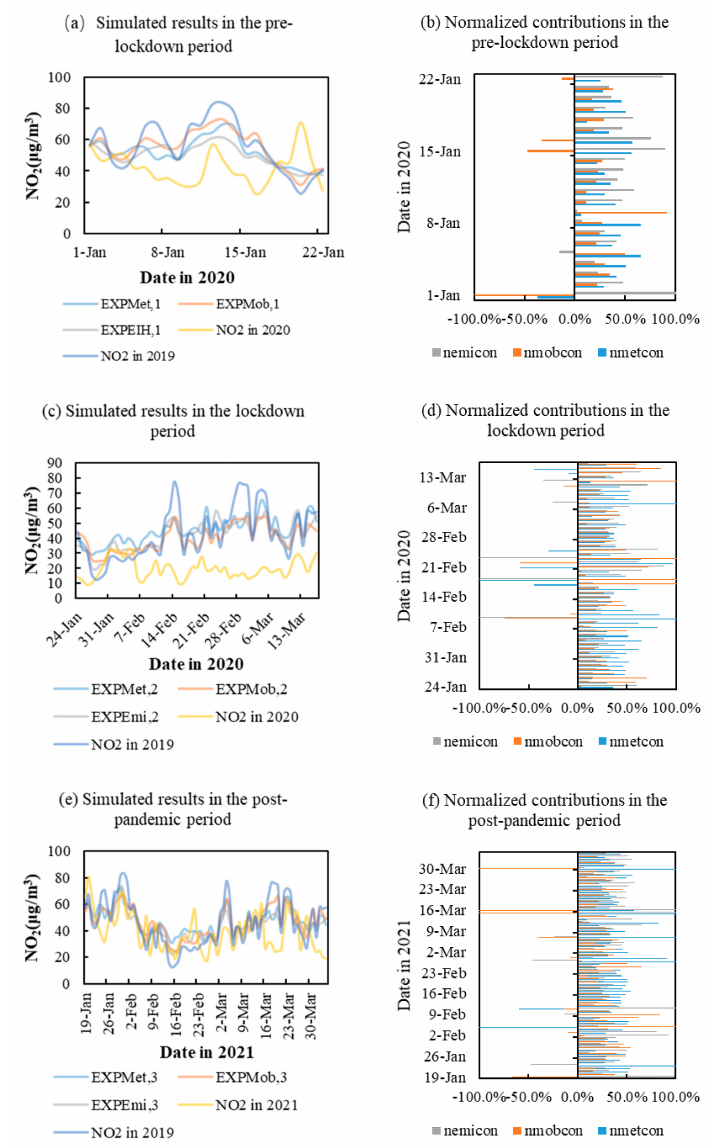
Figure 5. The simulated NO 2 concentrations and the normalized contributions in three periods: ( a ) Simulated results in the pre-lockdown period; ( b ) Normalized contributions in the pre-lockdown period; ( c ) Simulated results in the lockdown period; ( d ) Normalized contributions in the lock- down period; ( e ) Simulated results in the post-pandemic period; ( f ) Normalized contributions in the post-pandemic period. ( NCon ( Met , i ) , NCon ( Mob , i ) and NCon ( EIH , i ) mean the normalized contri- butions of meteorological conditions, human mobility and emissions from industry and households. EXP Met,i means the simulated NO 2 concentrations in RF model run with meteorological variables in i period and other variables in 2019; EXP Mob,i means the simulated NO 2 concentrations in RF model run with variables about road traffic in i period and other variables in 2019; EXP EIH,i means the simulated NO 2 concentrations in RF model run with variables about emissions of industry and households in i period and other variables in 2019, where i = 1 means the pre-lockdown period, i = 2 means the lockdown period and i = 3 means the post-pandemic